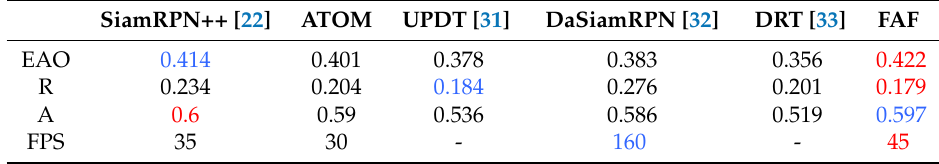
Table 3. Comparison with state-of-the-art trackers on the VOT 2018 dataset. The results are presented in terms of expected average overlap (EAO), accuracy value (A), and robustness value (R). The best and second results are in red and blue, respectively.